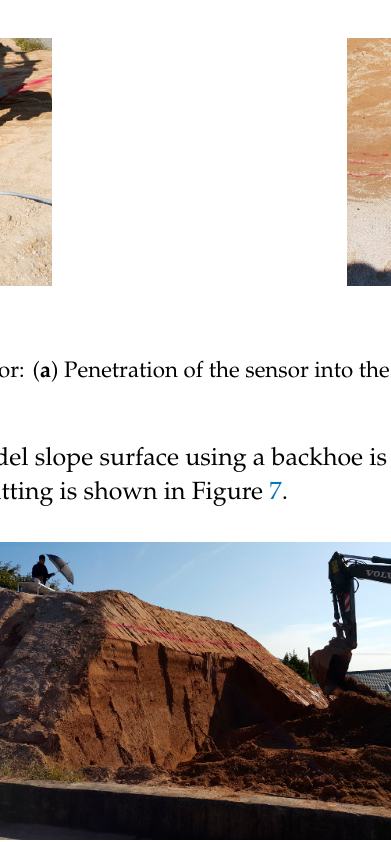
Figure 6. Slope cutting by a backhoe. Figure 7. Slope failure after cutting.